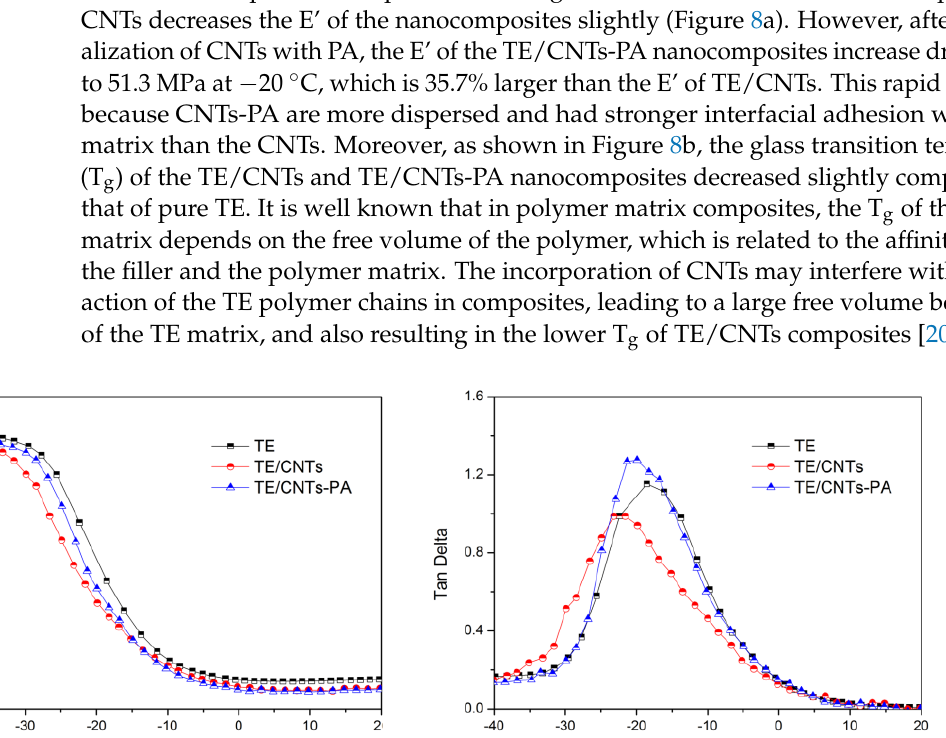
The dynamic storage modulus (E’) and the loss tangent (tan δ ) versus the tempera ‐